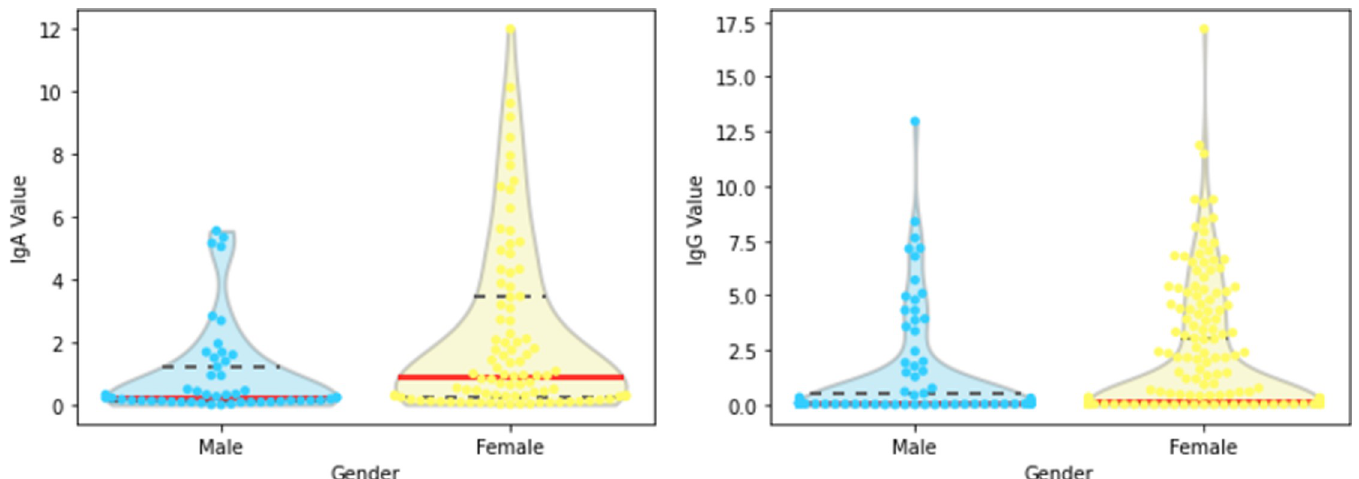
Fig 7. Violin plots with gender and values of (a) IgA and (b) IgG; medians in solid red lines, third quartiles in dashed lines.